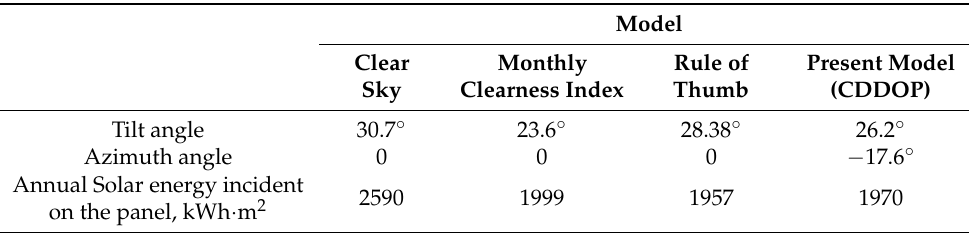
Table 2. A comparison of optimum tilt angle and total incident irradiation on a solar panel